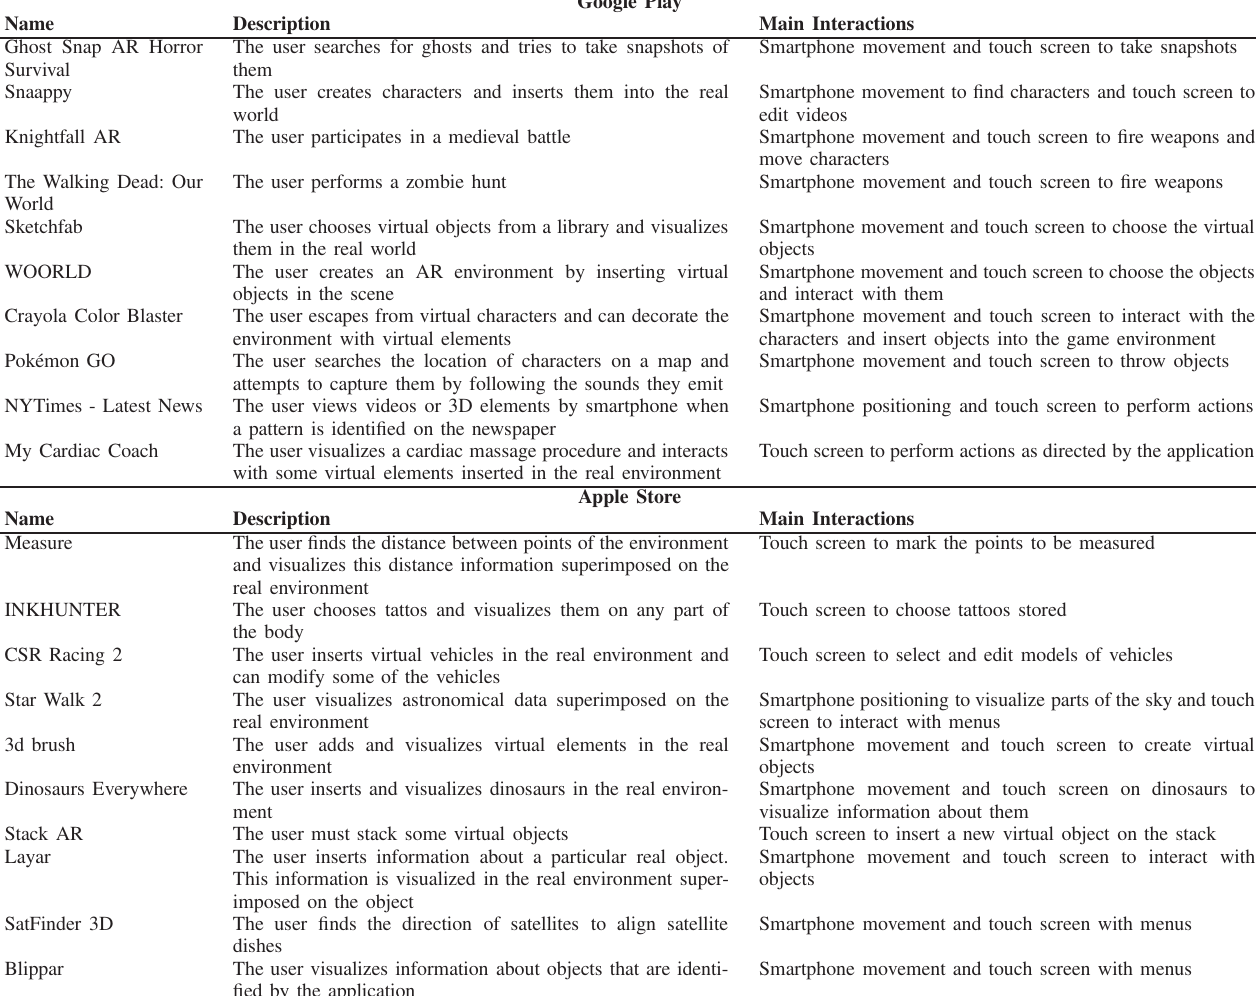
Table I T EN FIRST APPLICATIONS WITH THE FEATURES OF AN AR SYSTEM FOUND ON G OOGLE P LAY AND THE A PPLE S TORE WHEN THE SEARCH IS PERFORMED USING THE TERM “A UGMENTED R EALITY ”. T HE SEARCH WAS CONDUCTED ON A UGUST 6,